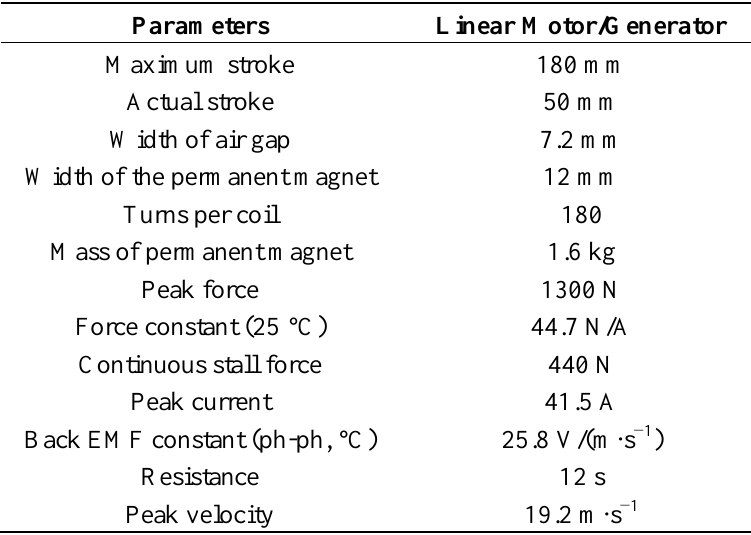
Figure 8. The connection diagram of the system. Table 3. Parameters of the linear